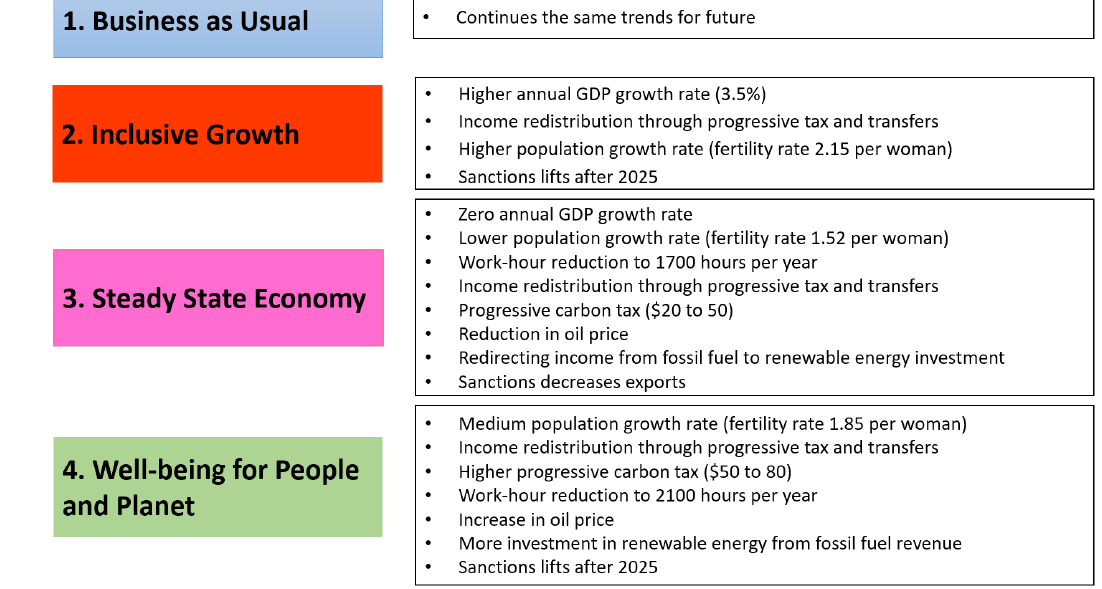
Figure 5. Four scenarios of this